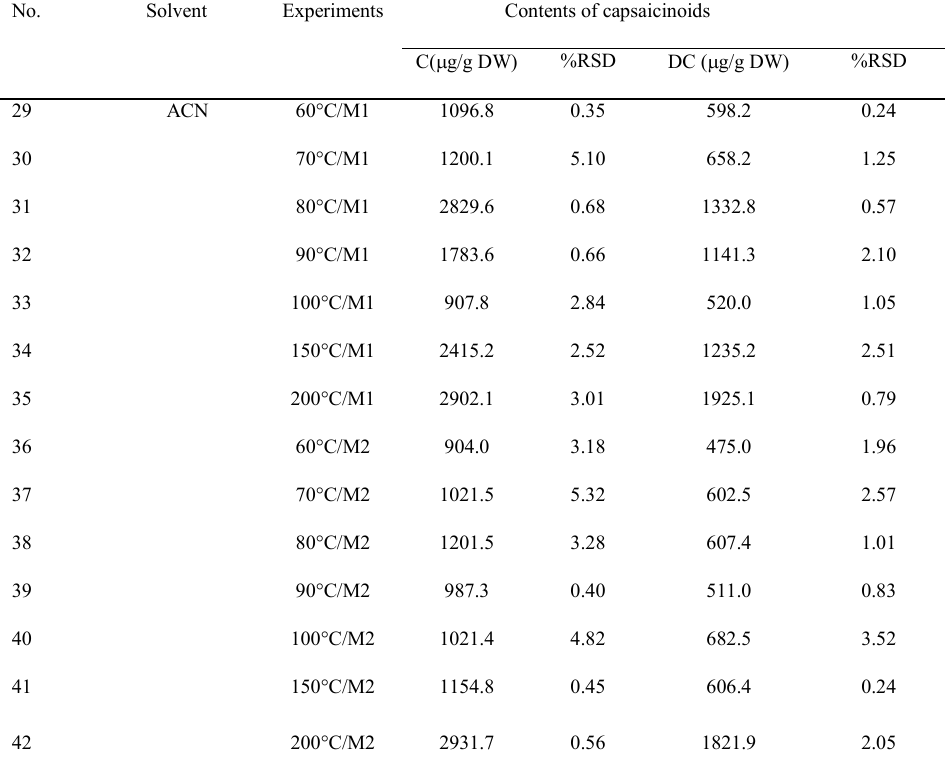
Table 2(c). Contents of capsaicinoids obtained from various conditions of ASE